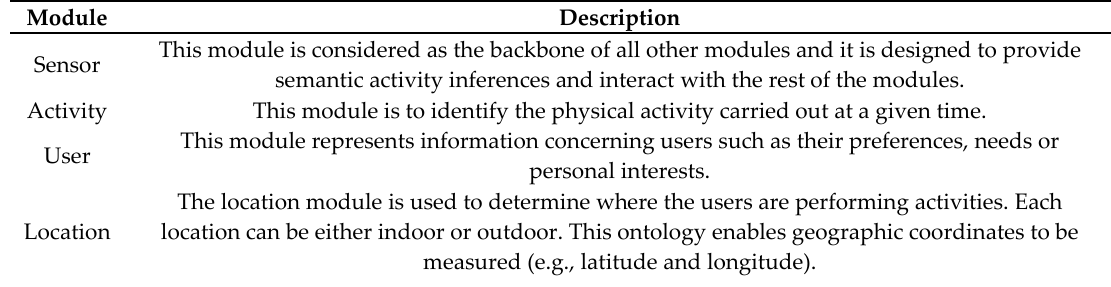
Figure 5. Overview of the Modular Activity Recognition Ontology (MAROlogy) model including its main modules. Table 2. Ontology module